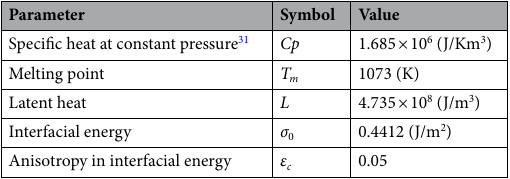
Table 1. Input parameters for